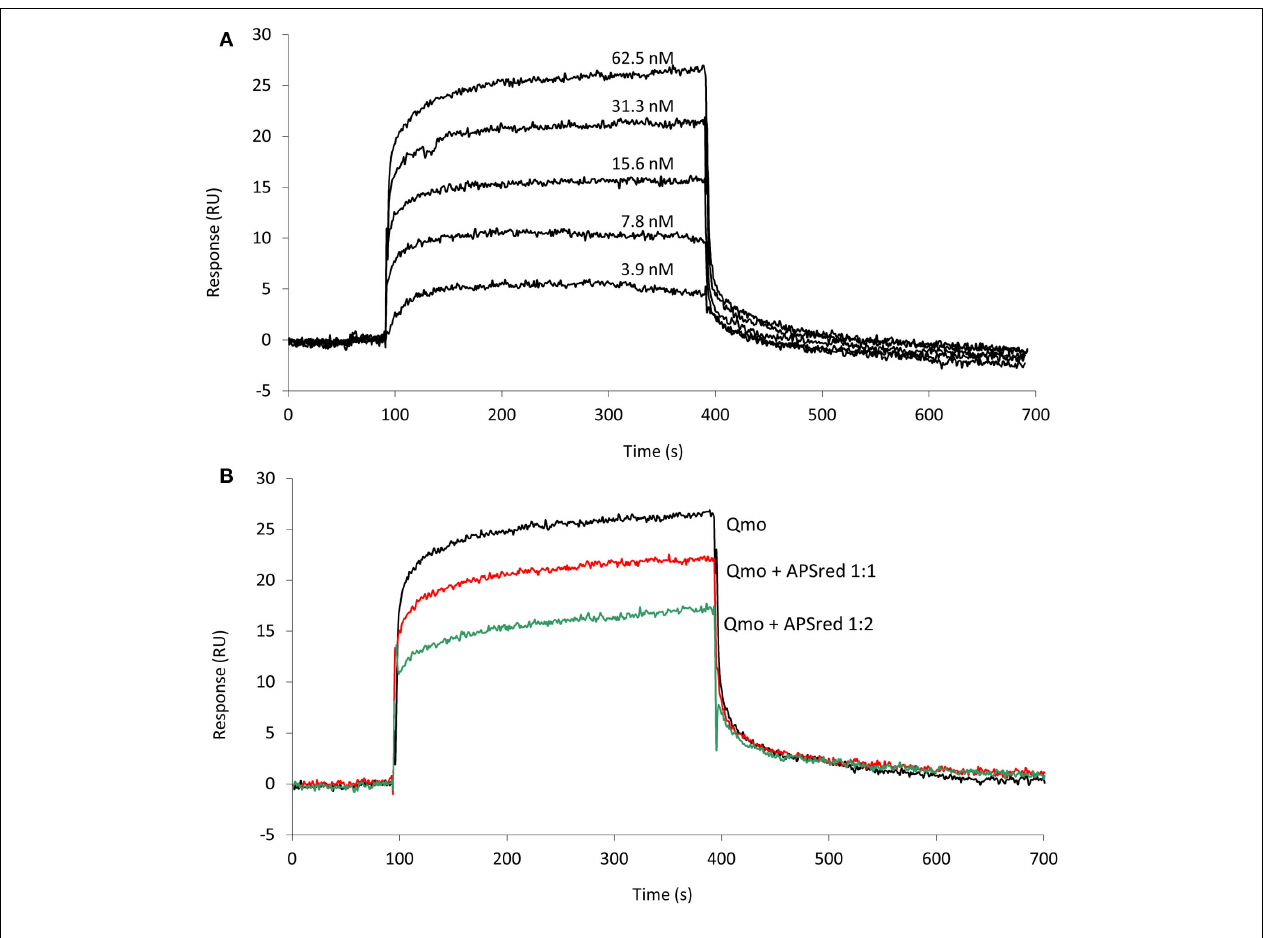
7.8, 3.9nM QmoABC at 15 μ l/min flow rate and 25˚C. (B) Competition experiment where QmoABC (62.5nM) was mixed with 62.5 (1:1) or 125nM (1:2) of AprAB before